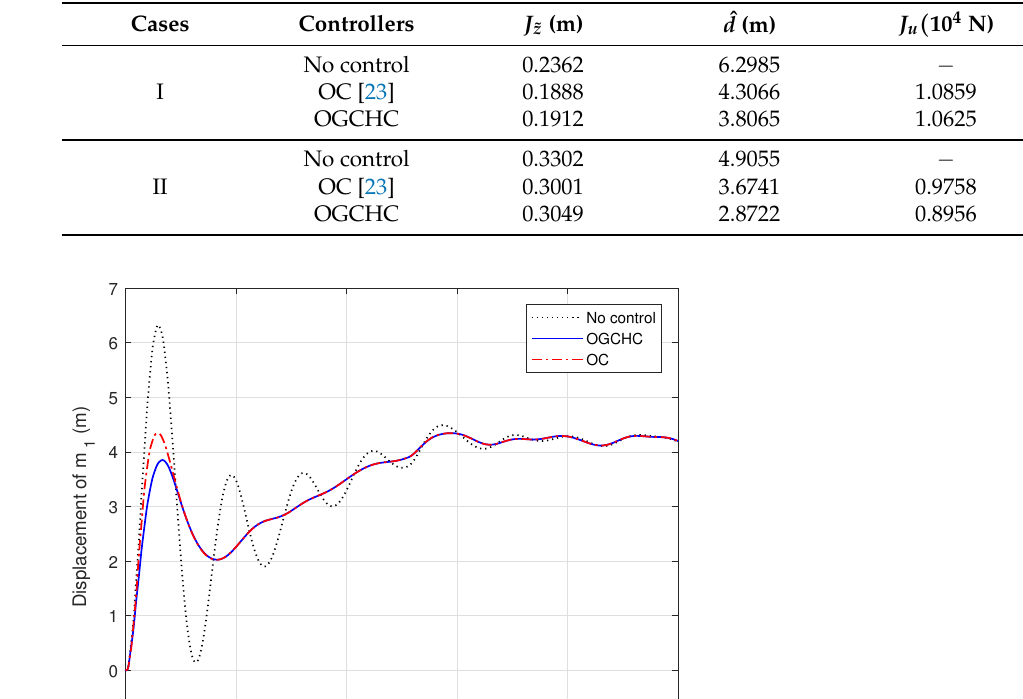
Table 3. Performance indices of the riser without control, with OC and OGCHC.